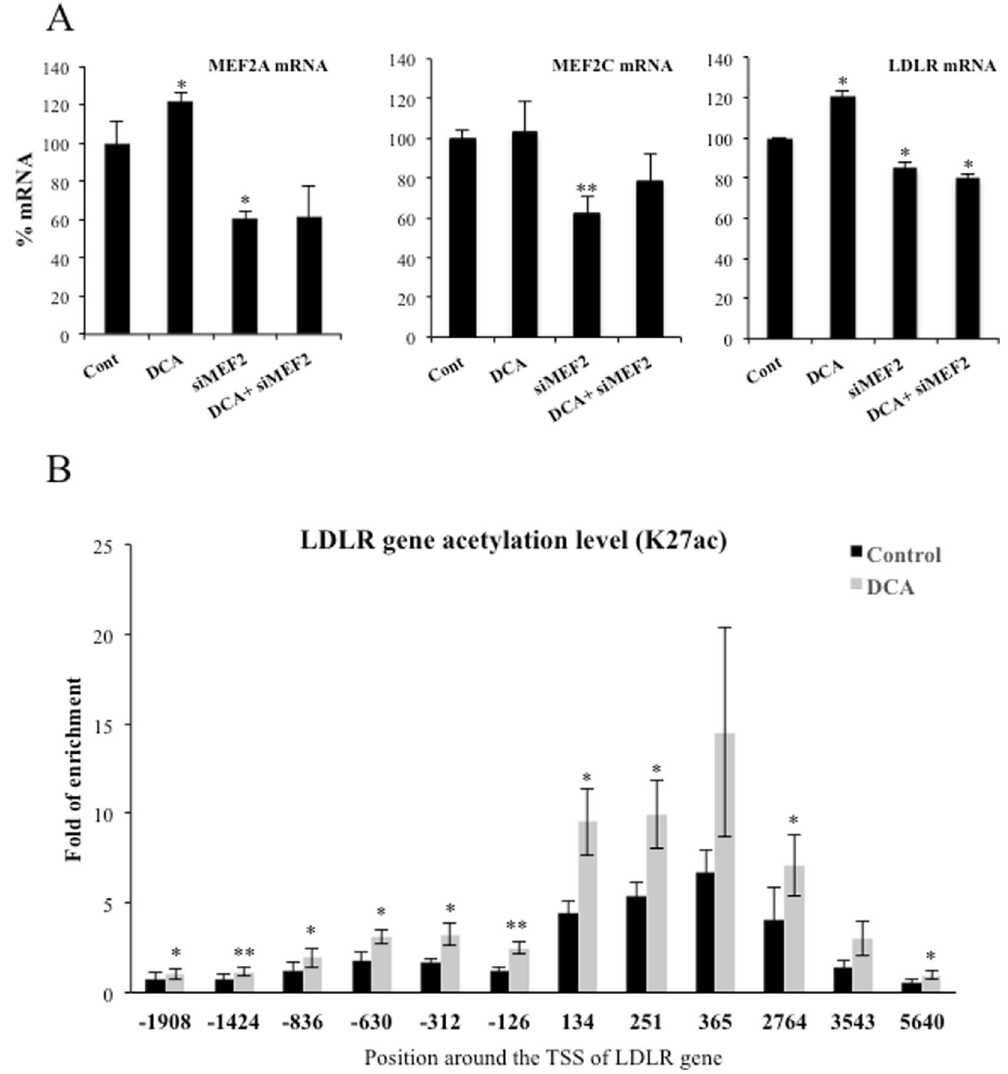
Figure 7. DCA required the transcription factor MEF2 to target LDLR promoter. ( A ) OCI-AML3 cells were transfected with 40 nM siRNA control or with 20 nM siRNA for each MEF2A and MEF2C (siMEF2). Twenty- four hours later cells were incubated for 24 h with 10 mM DCA. mRNA expression was analyzed by qPCR and represented as the % of mRNA compared to cells transfected with the empty vector. ( B ) OCI-AML3 cells were incubated for 72 h with 10 mM DCA. Cells were prepared for ChIP analysis using an antibody against H3 acetylation on lysine 27. Acetylation was revealed at different points of the LDLR promoter by using specific oligonucleotides. Bar graphs represent means ± SD; * p < 0.05, ** p < 0.01, *** p < 0.005 student t-test compared to empty vector transfected cells